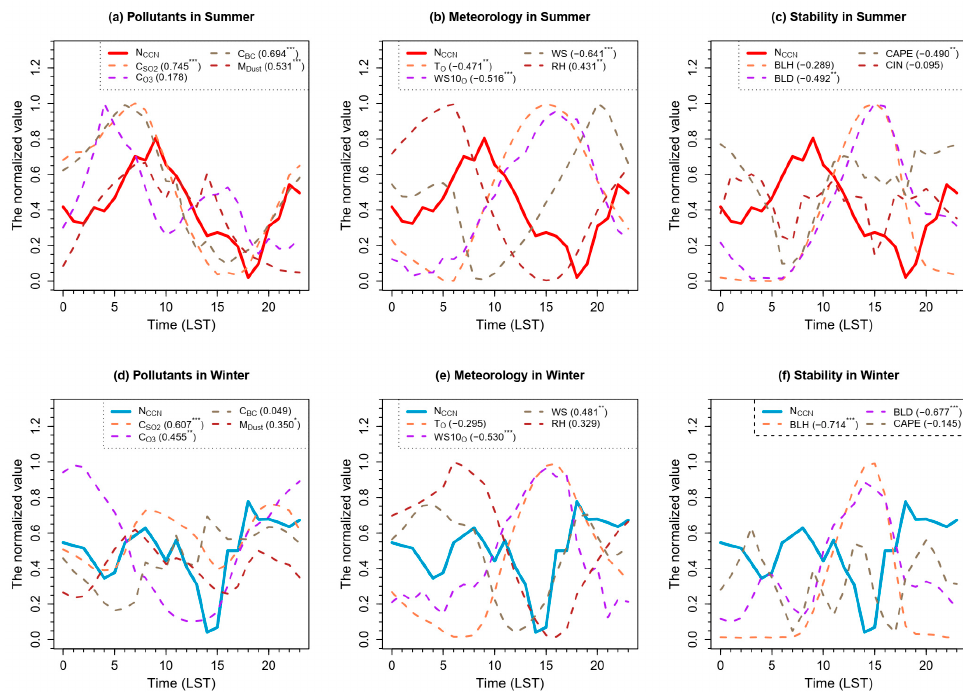
Figure 4. The hourly-averaged diurnal variations (normalized) of ( a , d ) pollutants (C SO2 , C O3 , C BC and M Dust ), ( b , e ) meteorological variables (T O , WS10 O , WS and RH), ( c , f ) atmospheric stability var-